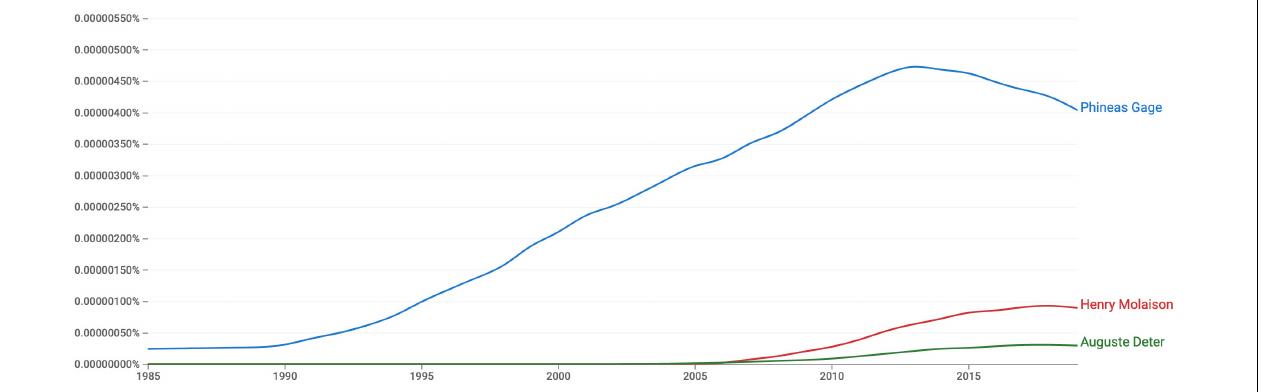
FIGURE 1 | This Google Ngram for English books from 1985 to 2019 shows a steeply increasing interest in Gage’s case since the early 1990s (blue line). Two of the other “essential landmark case reports” discussed by Benjamin et al. (2018), Auguste Deter and Henry Molaison, are shown for comparison (green and red line, respectively). The other clinical cases discussed by these authors (Louis Victor Leborgne and Solomon Shereshevsky) received less attention in English books (not shown on the graph). Source: